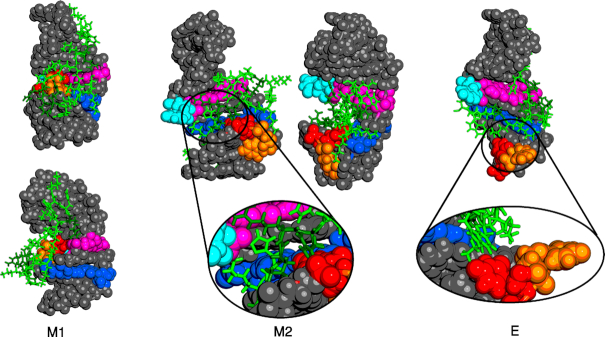
Lowest energy structures located for the binding of ARM to the shortened RNA 7SK hairpin model. Left: For the M1 configuration the peptide (green) is only on the surface of the RNA, and due to the closed major groove, no favourable interactions can form. Centre: In the M2 configuration the peptide can access the major groove and form interactions with the nucleotides of the hairpin, in particular with nucleotides of the GAUC/GAUC motif. The Arg residues (dark green) are deep in the opened groove and interact strongly with U63 (cyan) and U40 (red). The proline in the middle of ARM is also deeply buried, giving the peptide the flexibility to interact simultaneously with the GAUC/GAUC, U40 and U63. Right: In the extended configuration the 7SK motif is exposed, but the distance between U63 and U40 is increased, preventing strong interactions of the peptide with all three regions of the RNA at the same time, lowering the binding energy, and potentially the binding specificity.